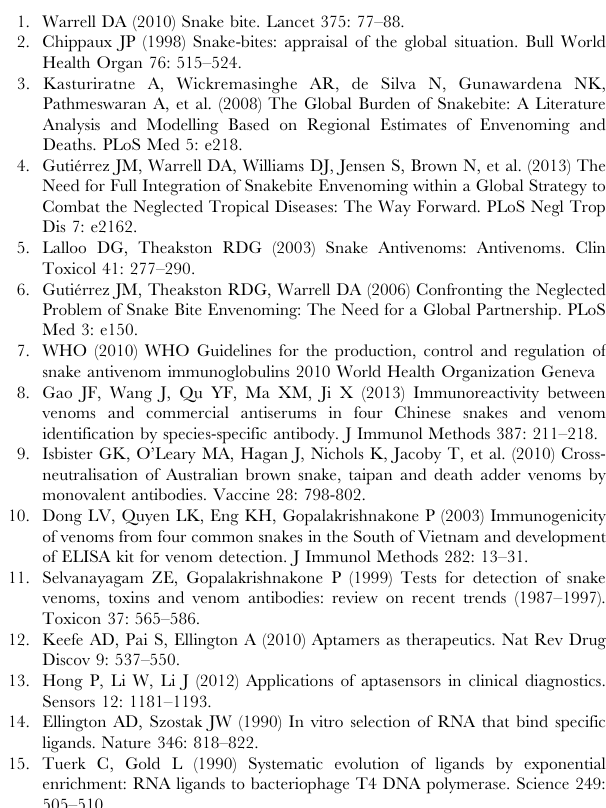
selection. Electrophoresis on 3% agarose after 18–26 cycles of PCR amplification. Lane 1: 20 bp DNA Ladder (TaKaRa); Lanes 2–5: 18, 20, 22, 24 and 26 cycles of PCR. The products of 20 cycles of PCR amplification were relatively specific fragments. (TIF) Figure S2 The secondary structures of aptamers b B-1, b B-19, b B-20 and b B-32. (TIF) Figure S3 K d measurements of b B-19 and b B-32 by fluorescence anisotropy. A) b B-19, K d = 530 6 58 nM; B) b B- 32, K d = 995 6 138 nM. (TIF) Table S1 Selection parameters of each SELEX round.